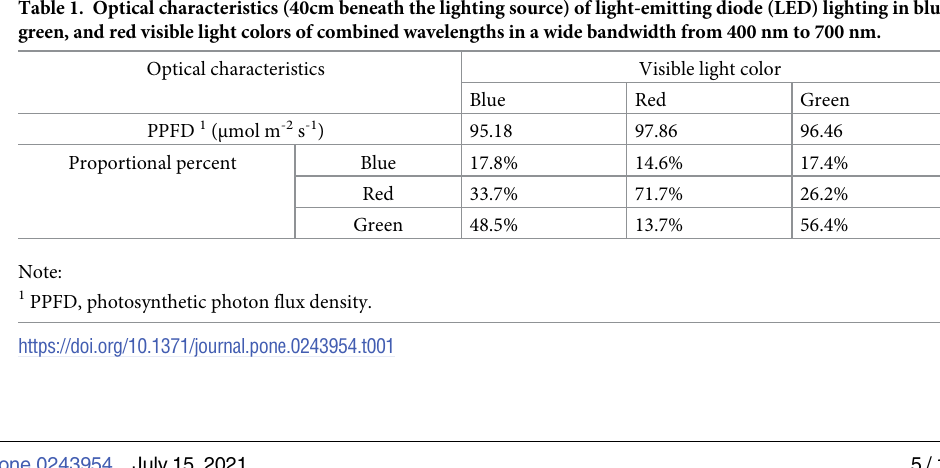
Table 1. Optical characteristics (40cm beneath the lighting source) of light-emitting diode (LED) lighting in blue, green, and red visible light colors of combined wavelengths in a wide bandwidth from 400 nm to 700 nm.